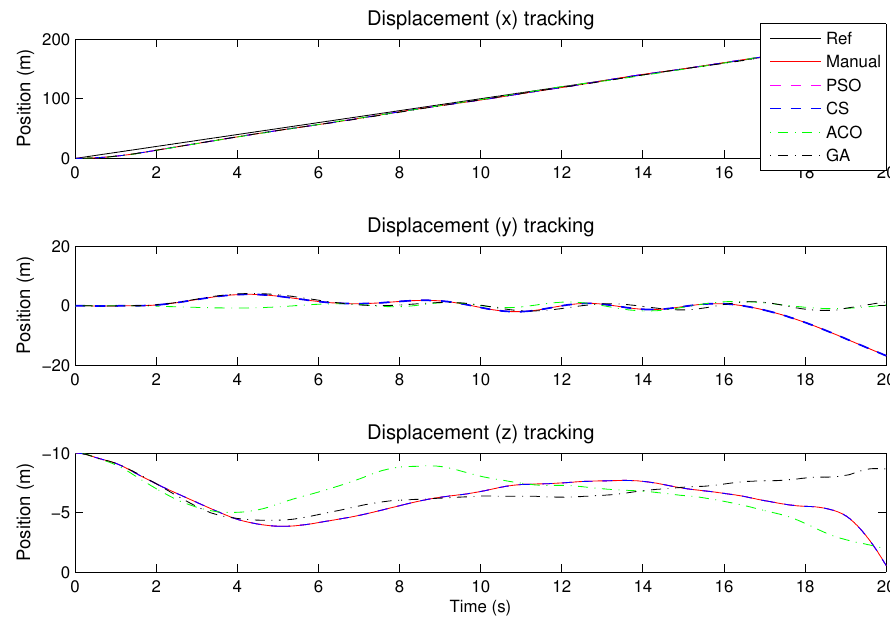
Figure 12. The nonlinear rotorcraft position time history 10